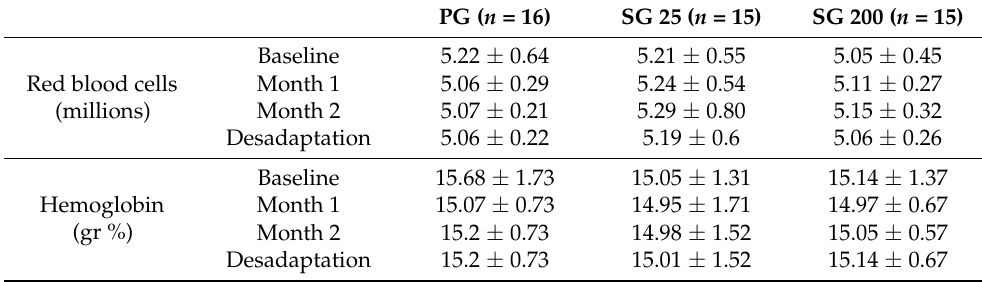
Table 6. Red blood cells at the